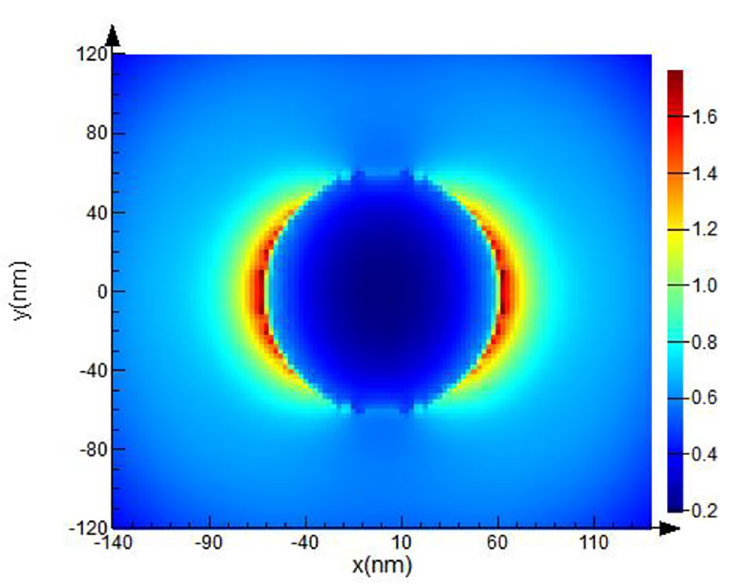
Fig 4. FDTD model of Pt NPs with 50 nm radii for λ = 251 nm excitation